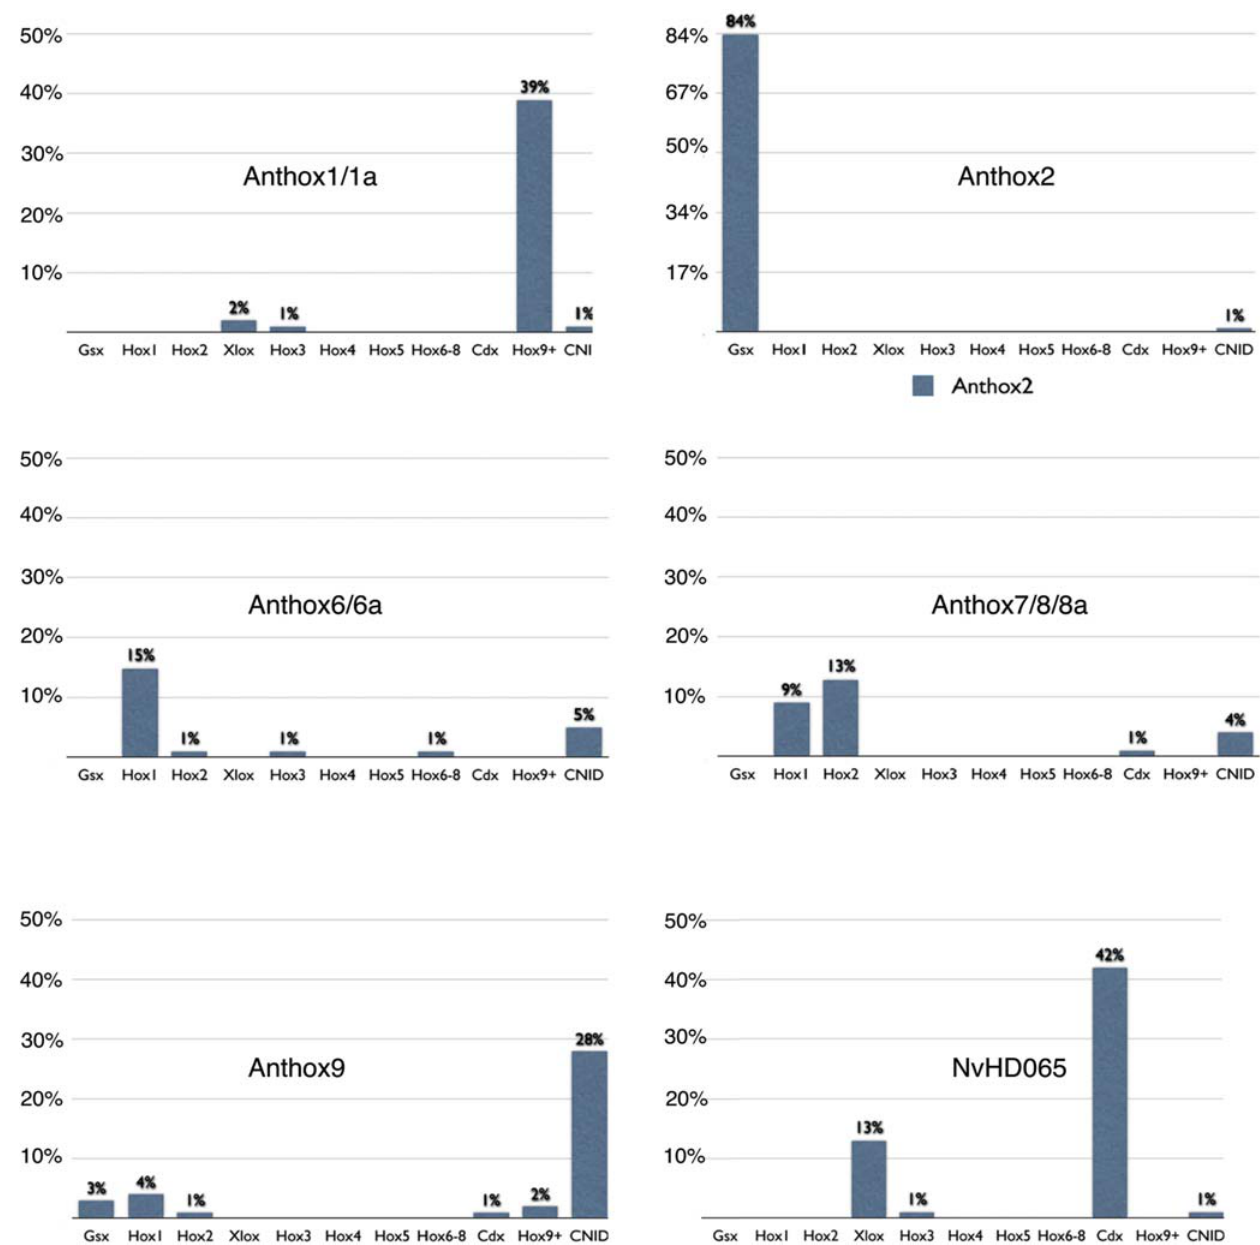
Figure 6. Mean statistical support for select phylogenetic groupings. The mean statistical support for hypothetical clades linking each of six Nematostella Hox/ParaHox lineages with potential homologs in the Bilateria is depicted graphically. The mean statistical support is the average of the neighbor-joining bootstrap proportion, the Bayesian posterior probability, and the maximum-likelihood bootstrap proportion. It is expressed as a percent of trees in which the given grouping was recovered. Individual Nematostella genes were grouped into lineages (for example, anthox1- anthox1a) when the mean statistical support for the clade uniting them exceeded the mean statistical support for any other competing relationship. The final column depicts the highest support obtained for any pairwise relationship with another cnidarian homeodomain.